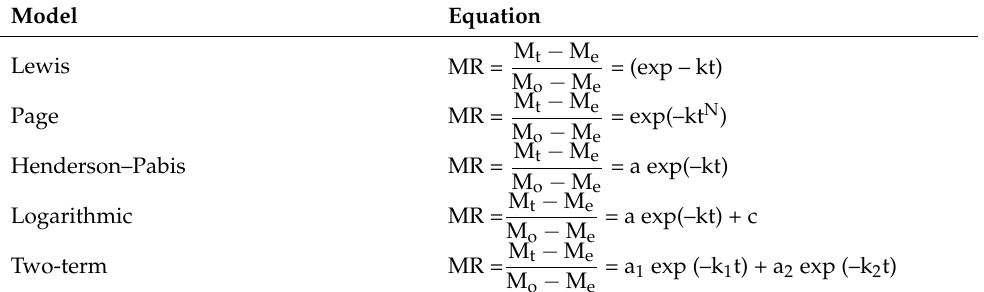
Figure 1. Visual appearance of Kyoho skin powder affected by drying temperature. ( A ) 303.15 K, ( B ) 313.15 K, ( C ) 323.15 K, and ( D ) 333.15 K. Table 1. Empirical models used to describe the drying kinetics of Kyoho skin 1